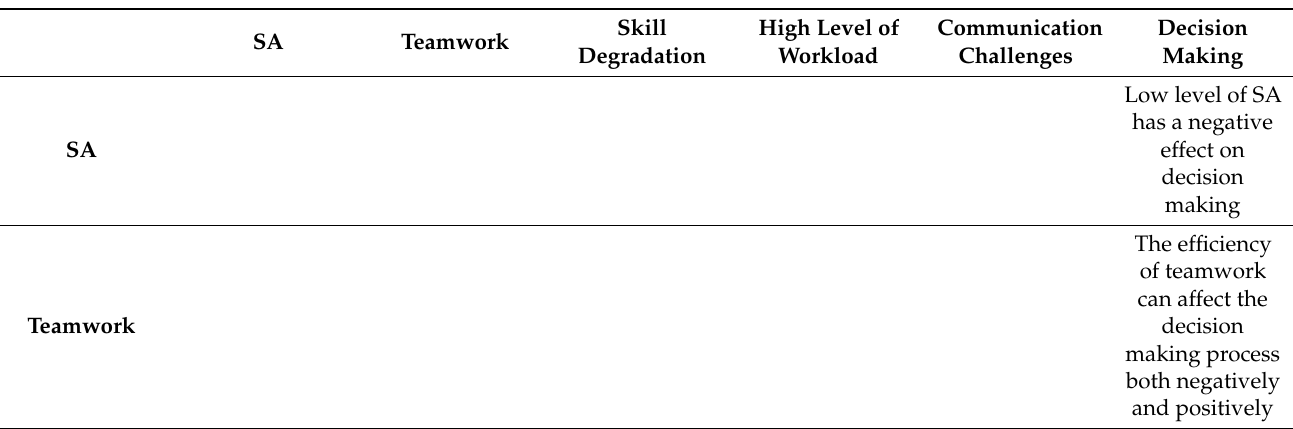
Table 3. Relationship matrix (relationships between human factor